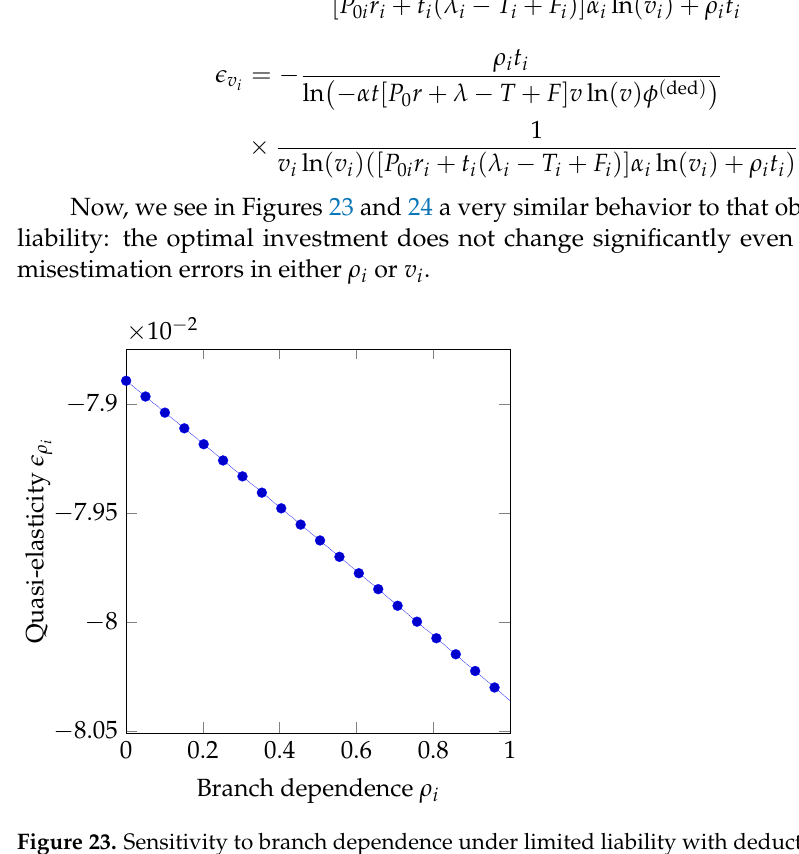
Figure 23. Sensitivity to branch dependence under limited liability with